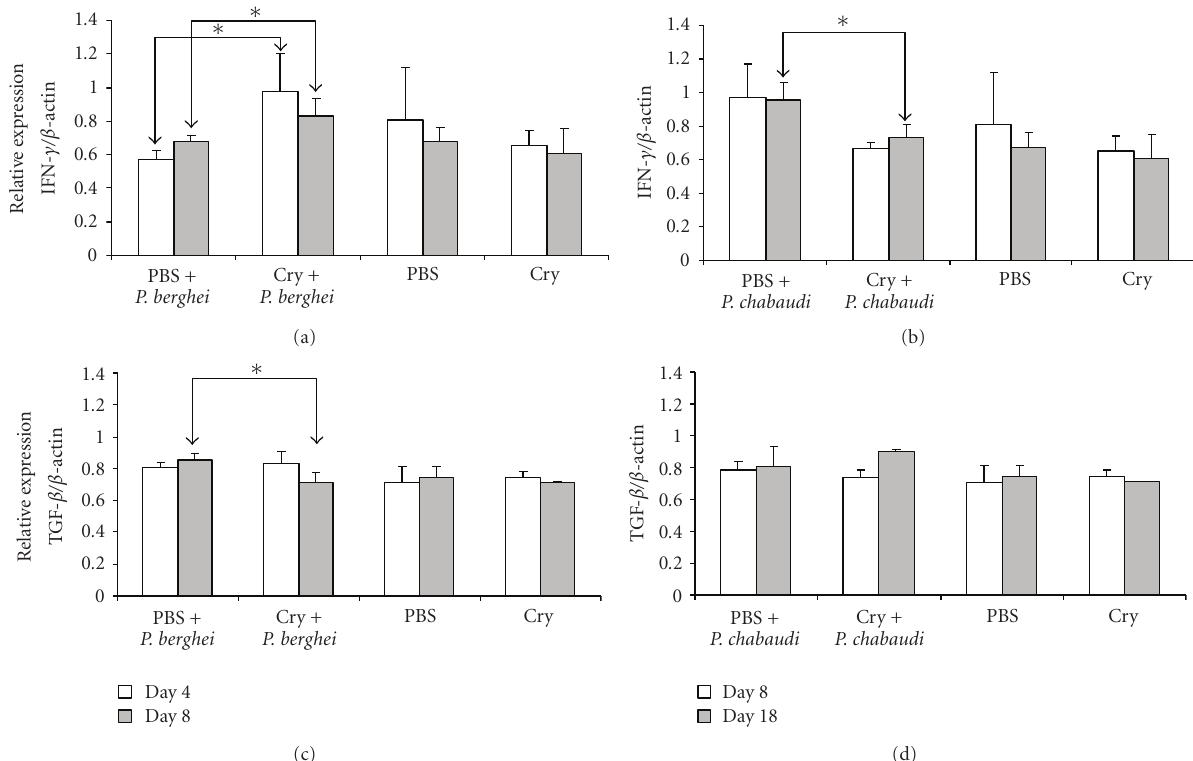
Figure 3: E ff ect of Cry1Ac on the mRNA expression of IFN- γ (a and b) and TGF- β (c and d) in mice infected with P. chabaudi AS or P. berghei ANKA. Mice were treated with Cry1Ac protoxin or PBS as a control. One day after the last injection, mice were infected with P. berghei ANKA or P. chabaudi AS. On days 4 and 8 PI (a and c) or days 8 and 18 PI (b and d), three mice from each group were killed, and their splenic mRNA was extracted and retrotranscribed. The cDNA obtained was used to amplify the β -actin gene and either IFN- γ or TGF- β by PCR in the same tube. PCR products were separated on 5% polyacrylamide gels. Bands were analysed by densitometry, and the results are shown as the absorbance of the corresponding cytokine divided by the absorbance of β -actin. Data are representative of two separate experiments. Asterisks indicate statistically significant di ff erences between the indicated